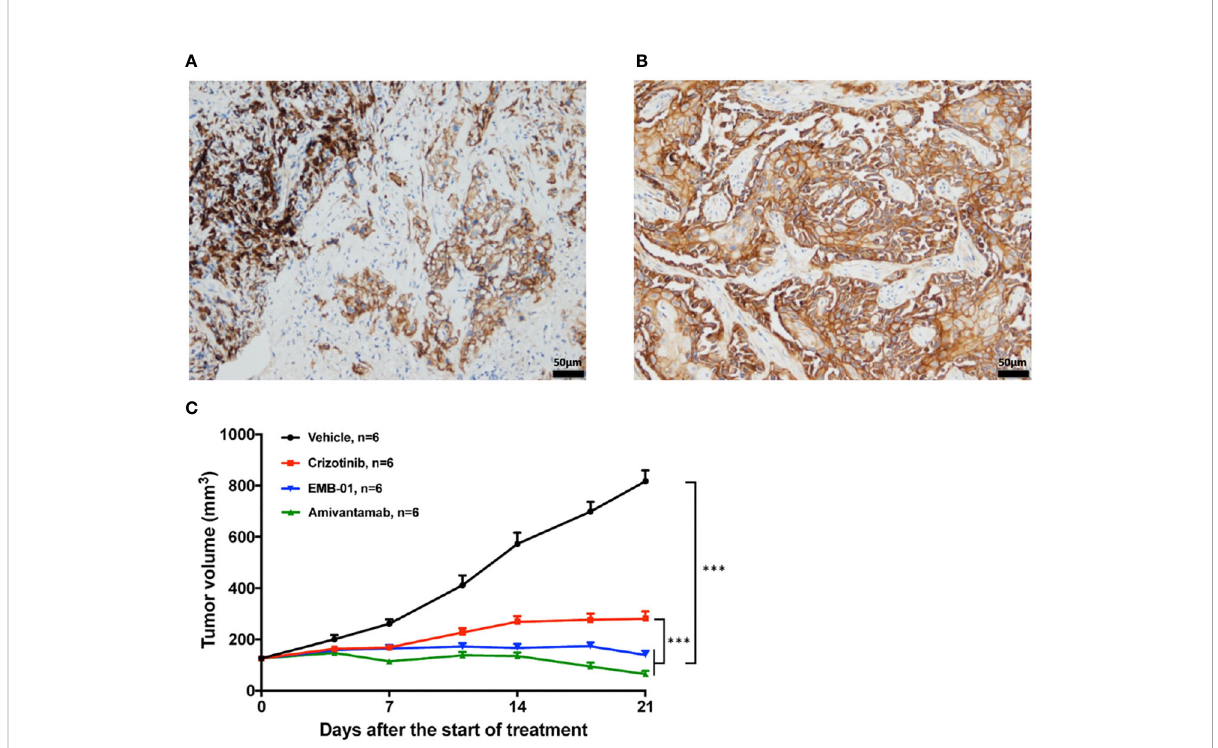
FIGURE 5 Representative pictures for EGFR IHC staining and the effect of EGFR/cMET bispeci fi c antibody on drug resistant PDX model. (A) IHC staining of EGFR in patient-resistant sample. (B) IHC staining of EGFR in PDX-resistant sample. (C) Tumor change in drug resistant PDX mice treated with vehicle, 50mg/kg crizotinib once daily, 16mg/kg EMB-01 once a week, 16mg/kg Amivantamab twice a week for 3 weeks. Tumor volume was measured and expressed as the mean ± standard error. ***p< 0.001 by two-way ANOVA Bonferroni ’ s